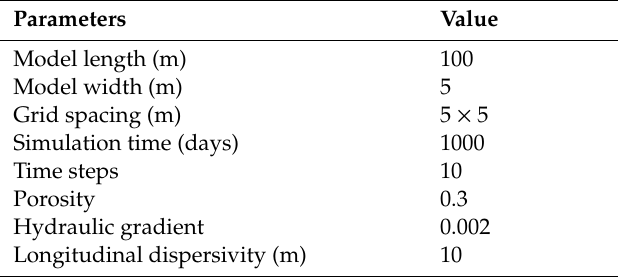
Figure 2. The conceptual model of the one-dimensional confined aquifer. The distribution of the reference log-conductivity field in Case 1 is presented in the background of the model. The black dot denotes the contaminant source and the red square denotes the observation well. The black arrow indicates the direction of groundwater flow. Table 1. Basic parameters of the reactive transport model in Case 1.